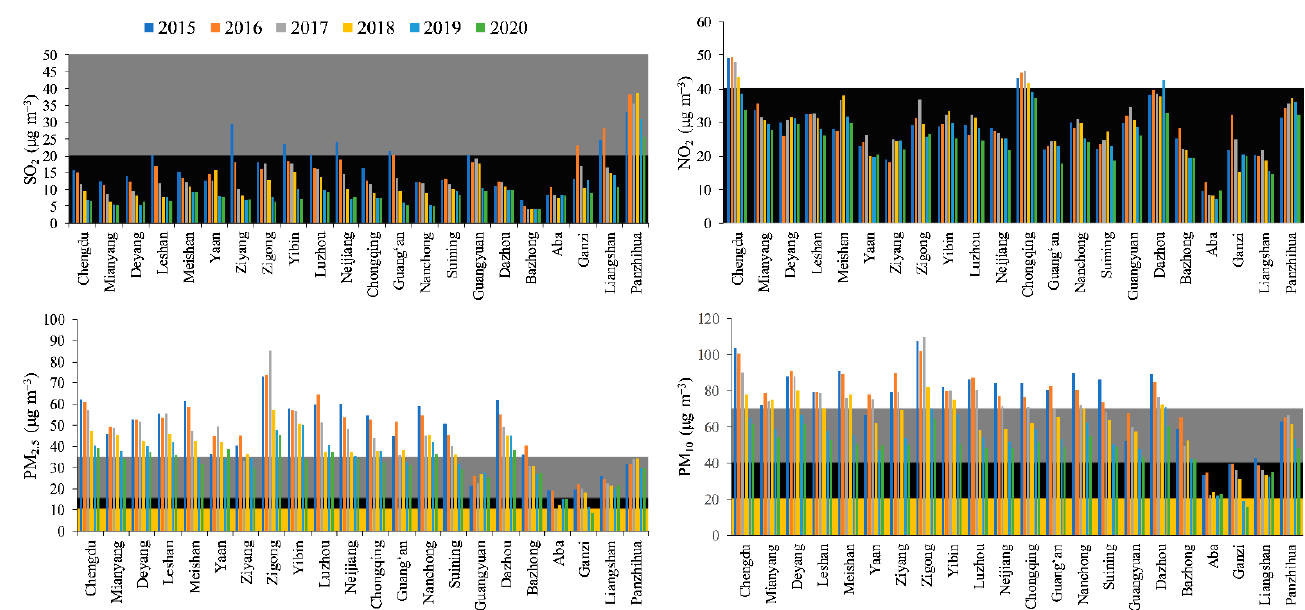
Figure 10. Annual mean concentrations of the pollutants at each site and comparison with the WHO guideline values (yellow shading) and National Grade-I (black shading) and Grade-II (dark gray shading) standards for air quality.